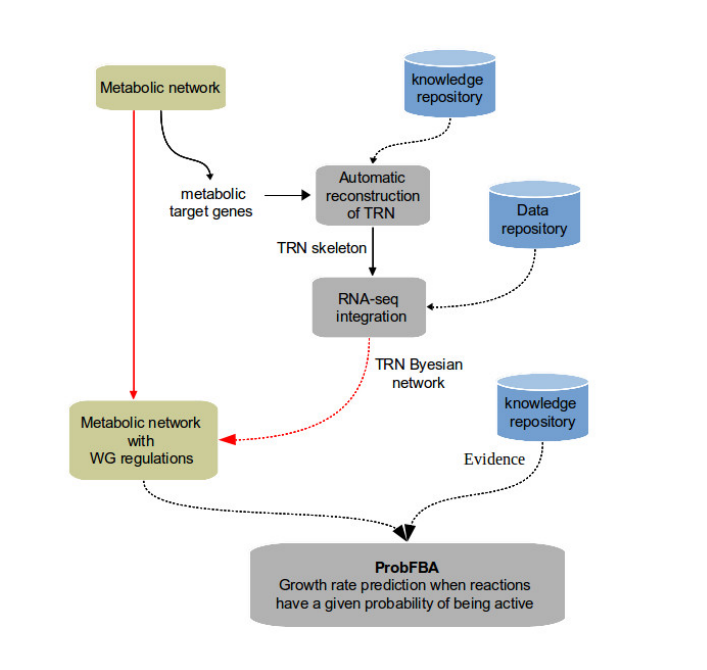
Figure 1. Overview of the process used to integrate the metabolic and regulatory network using